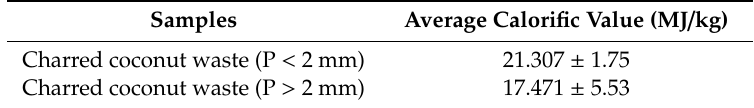
Table 3. Average calorific values of raw charred coconut waste (P < 2 mm, P > 2 mm).